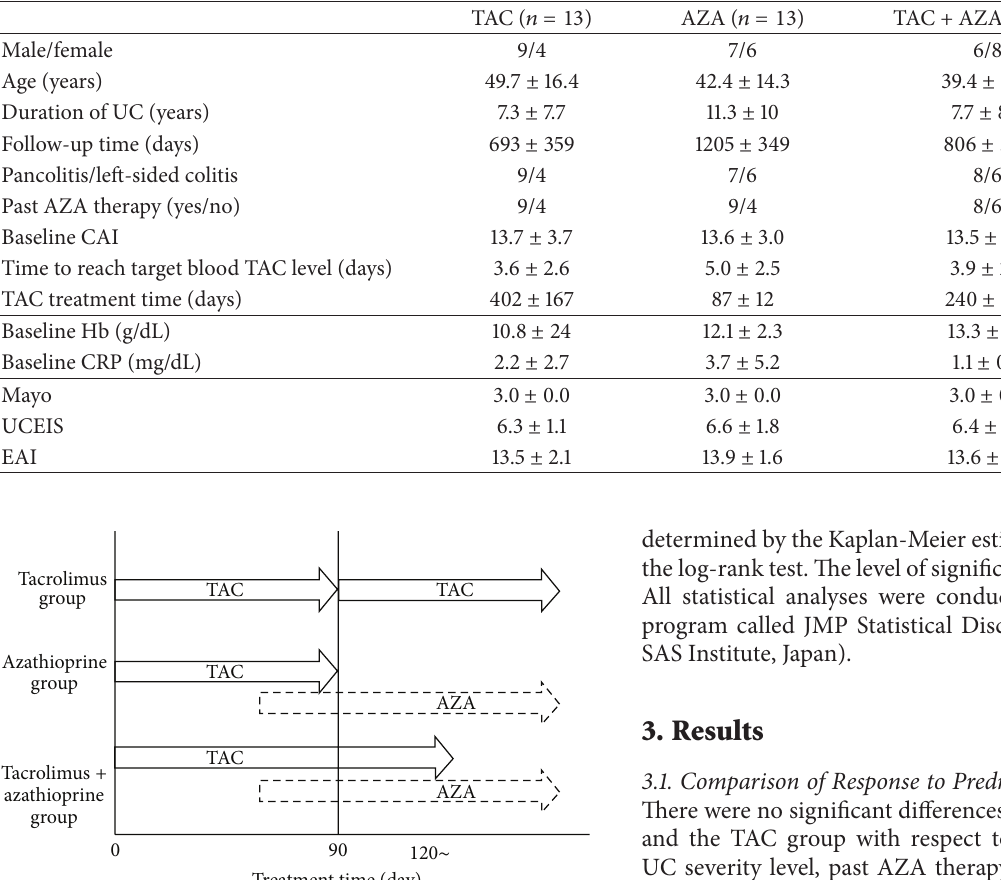
Table 2: Clinical characteristics of patients with ulcerative colitis (UC) treated with tacrolimus (TAC) group who were randomly assigned to maintenance therapy with TAC, AZA, or TAC + AZA.